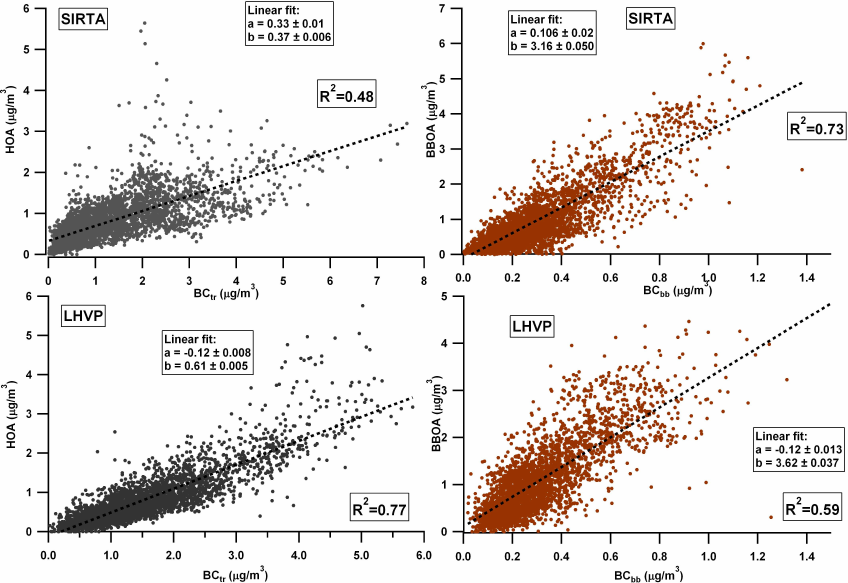
Fig. 11. Comparison of HOA and BBOA apportionment using PMF and the aethalometer methods. Orthogonal distance regression provides slopes of 0.55 and 0.56 for the HOA-BC tr plots and 3.83–3.9 for the BBOA-BC bb ones.